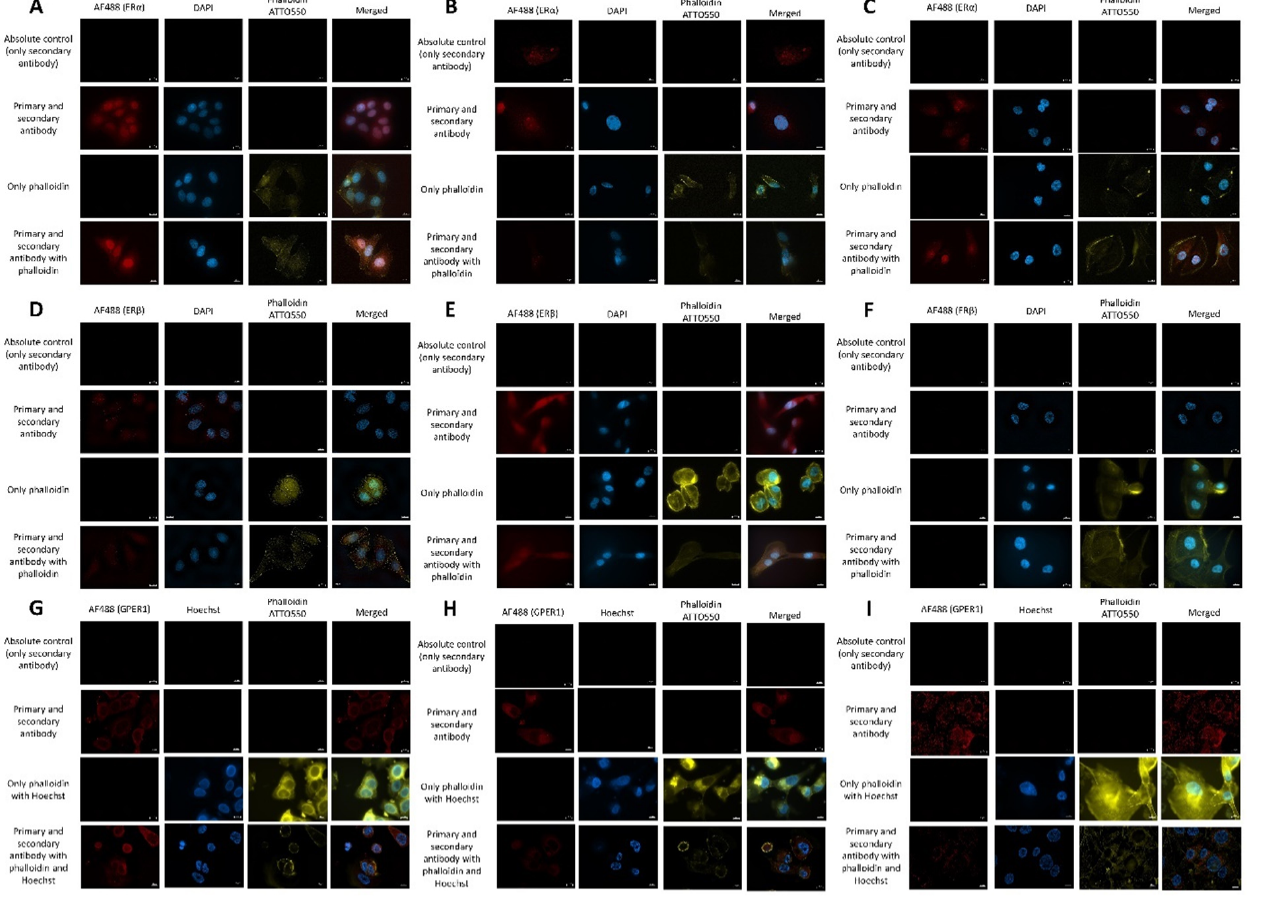
Figure 6. ER α (( A )-MCF7, ( B )-MDA-MB-231, ( C )-PANC1), ER β (( D )-MCF7, ( E )-MDA-MB-231, ( F )-PANC1) and GPER1 expression (( G )-MCF7, ( H )-MDA-MB-231, ( I )-PANC1) of our model cells. Images were captured by Celldiscoverer 7 after Triton lysis. Magnification is at 100 × , the scale bar is 10 µm.